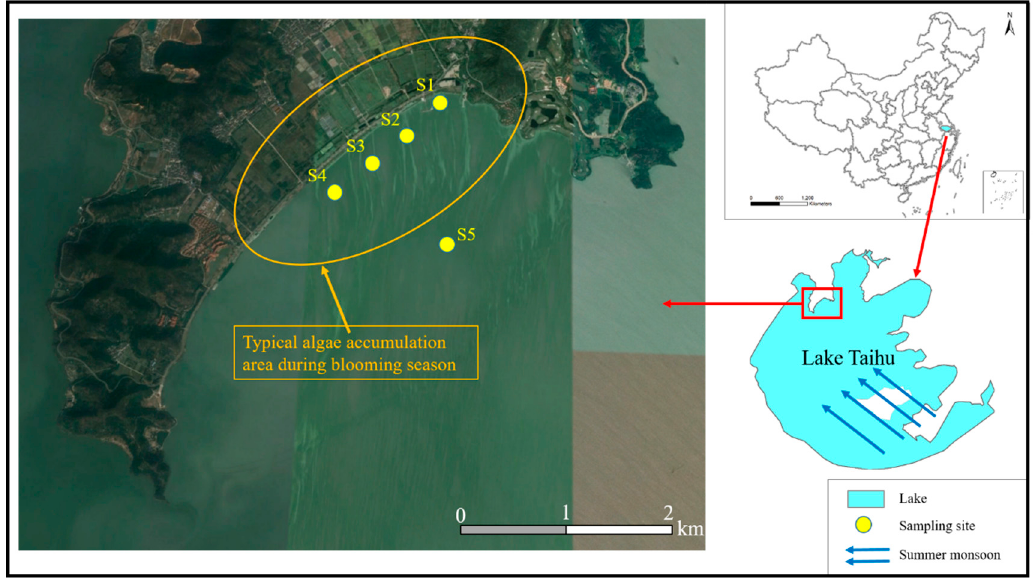
Figure 1. Location map of the sampling sites.